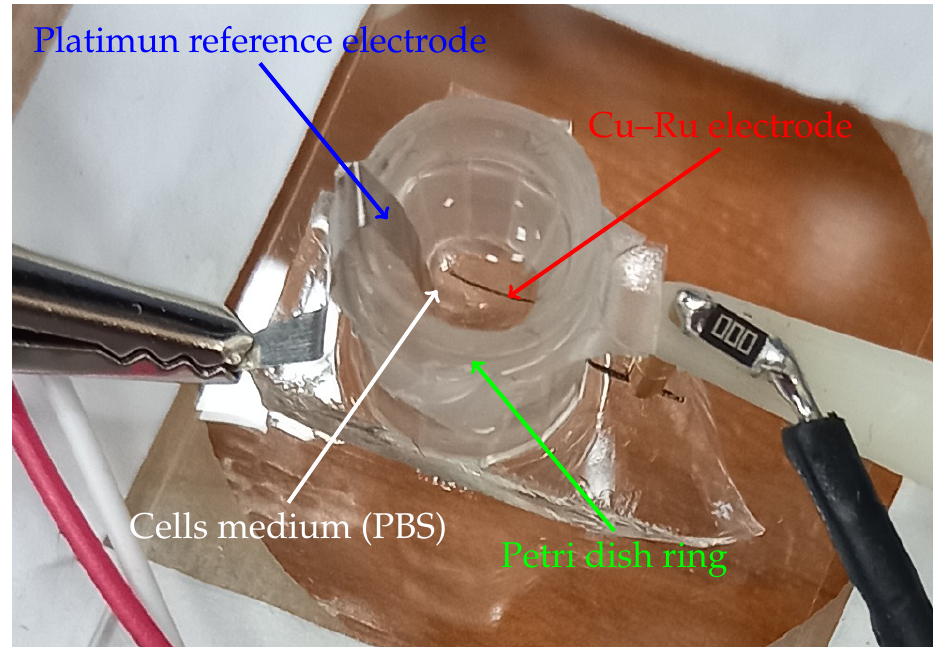
Figure 9. Macrophotograph of the copper–ruthenium